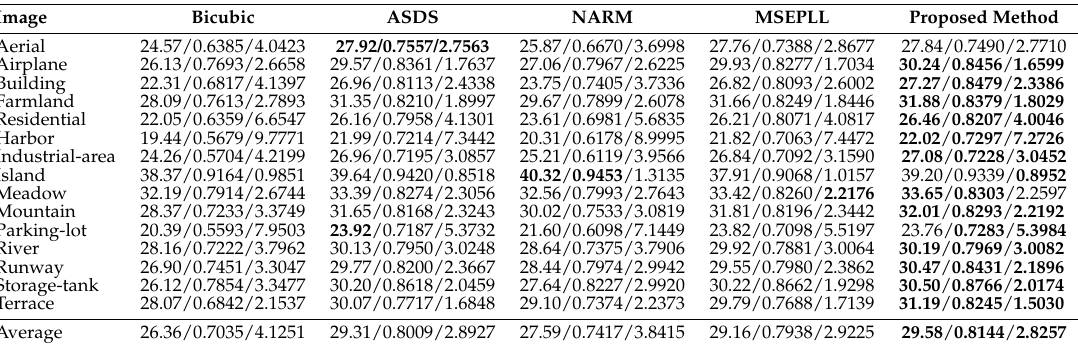
Table 3. PSNR/SSIM/ERGAS Results of Reconstruction for Test Images (Scale Factor = 3, Noise = 5). Image Bicubic